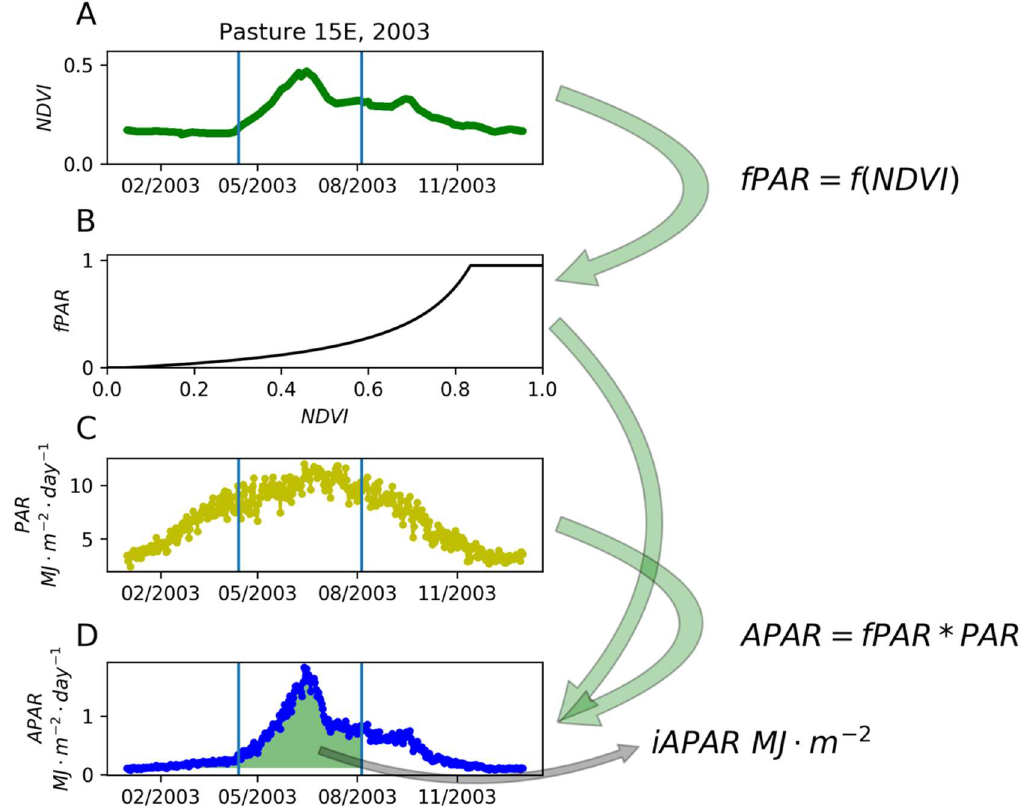
Figure 4. Example calculation of cumulative absorbed photosynthetically active radiation (iAPAR) (plot D) derived from NDVI (plot A), the fPAR to NDVI relationship (plot B), and incoming PAR (plot C) for pasture 15 East (LTGI moderate grazing intensity) during 2003.